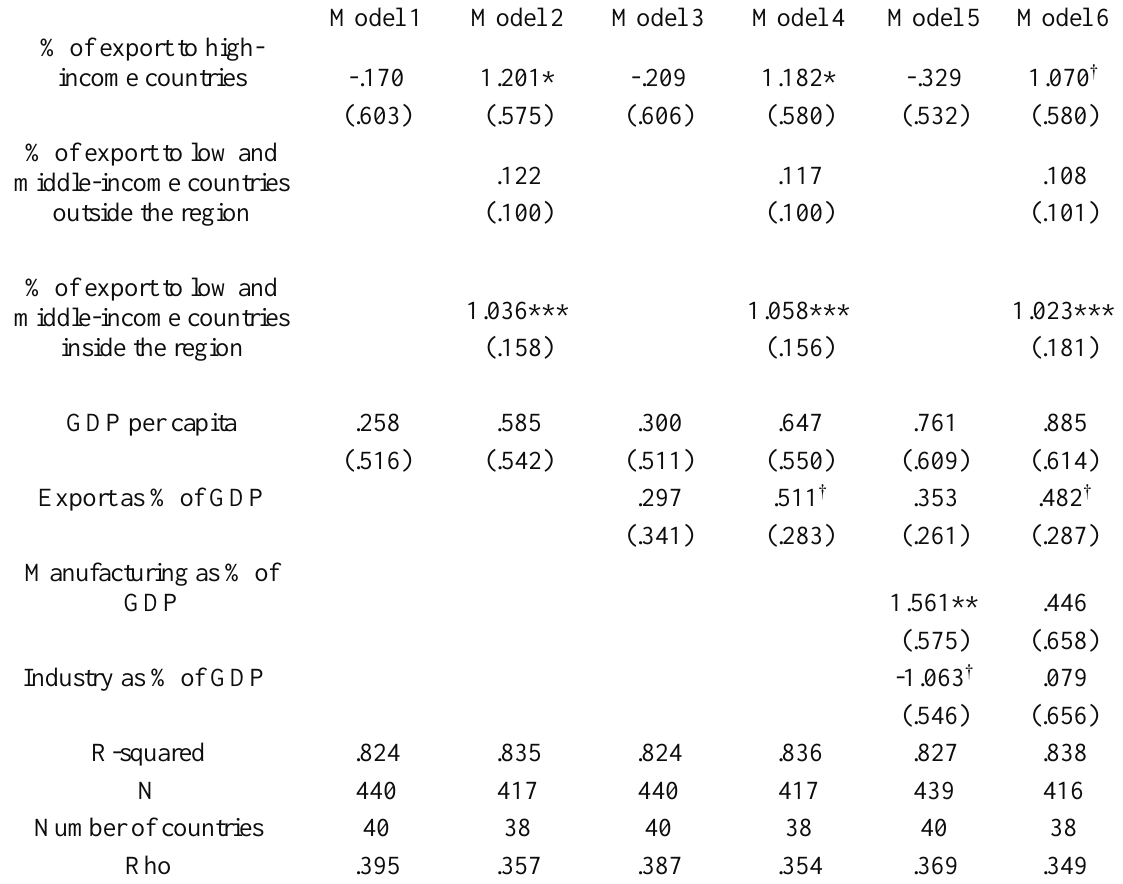
Table 5. Regression of Plastic Waste Export Trade Value, 2003-2013, Two-Way Fixed Effects PW Regression Model Estimates for 40 Non-High-Income